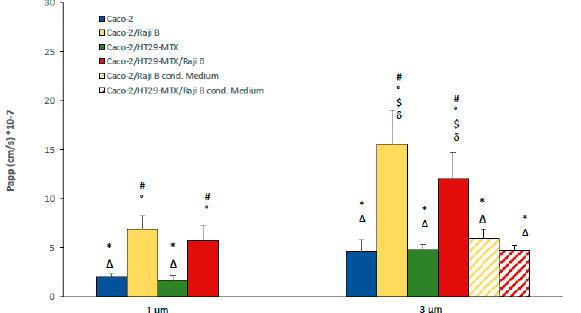
Figure 12. SiO 2 NPs translocation in Caco-2 monoculture in the different (co)-culture conditions on 1 µm and 3 µ m pore size inserts. On 3 µm pore, insert data on silica translocation in presence of Raji B conditioned medium are also reported. #versus Caco-2, *versus Caco-2/RajB; °versus Caco-2/HT29-MTX; Δ versus Caco-2/HT29-MTX/ Raji B, $versus Caco-2/Raji B medium; δ versus Caco- 2/HT29-MTX/ Raji B medium.